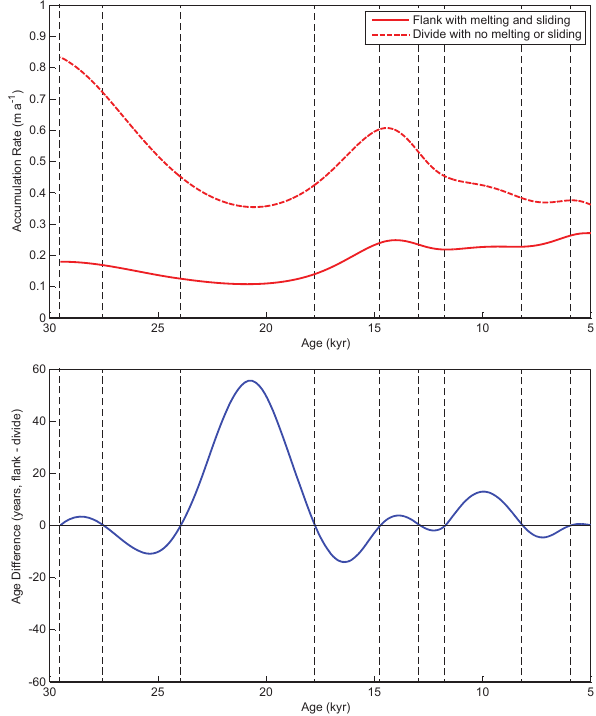
Figure 2. Accumulation rate (top panel) inferred with the ACCUM method with ice flow parameters for either a flank or divide site. The age difference (bottom panel) between the two